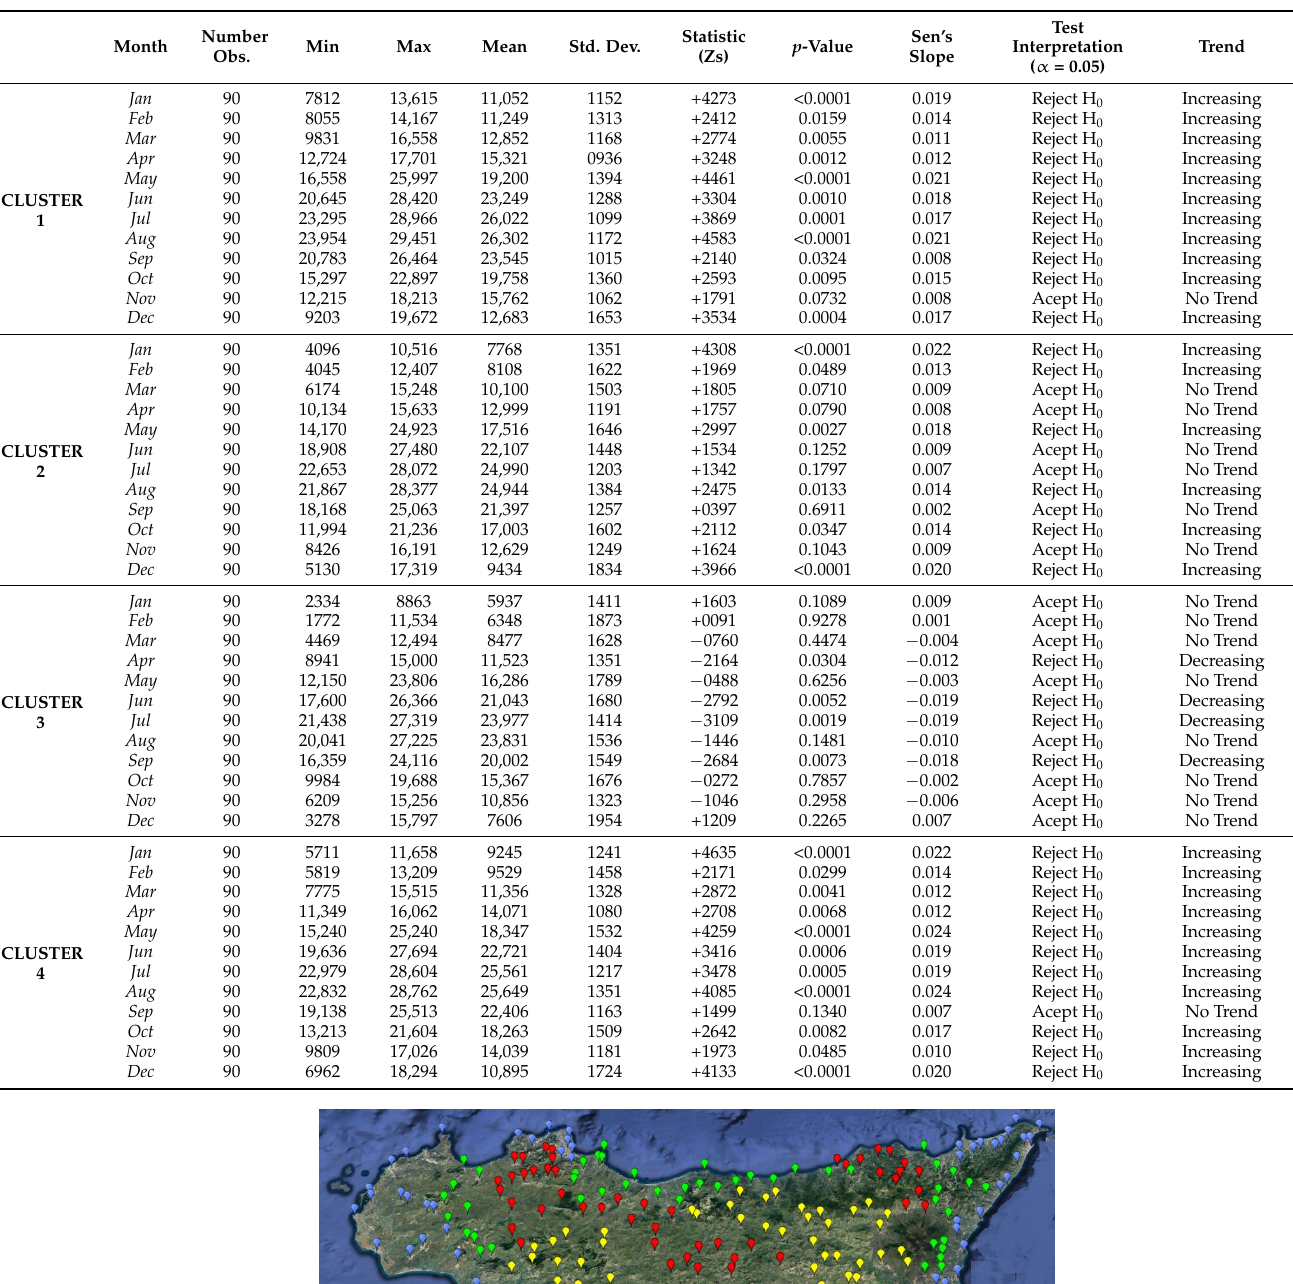
Table 1. Results of the Mann-Kendall test for temperature data in every Cluster.